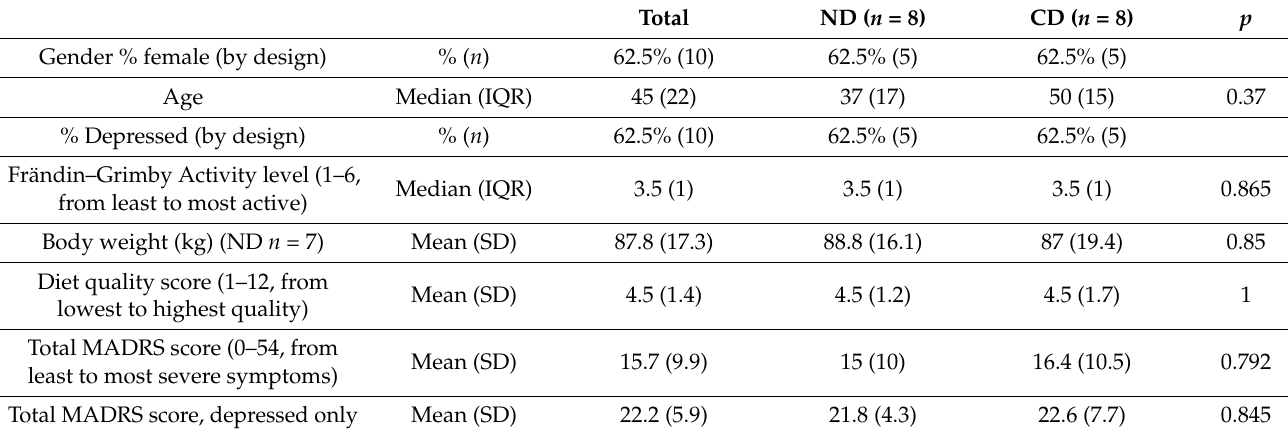
Table 2. Baseline characteristics of participants randomized to the healthy Nordic diet (ND) and control diet